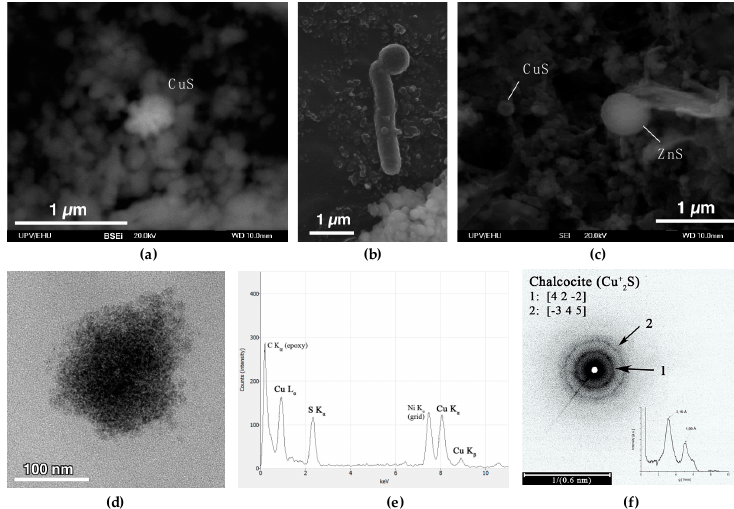
Figure 4. SEM ( a – c ) and TEM ( d – f ) images obtained on suspended particulate matter sampled at 43 m ( a ) and 47 m ( b – f ) depth in the acidic pit lake of Filón Centro in October 2018; ( a ) backscattered electron image of lenticular aggregate of chalcocite-like Cu sulfide; ( b ) mineralized bacterial rod associated with a spherical particle; ( c ) secondary electron image of globular ZnS with trace Cd and small darker particles which are globular Cu sulfides; ( d ) globular chalcocite (Cu 2 S) particle from SPM at 47m; ( e ) EDS pattern of the particle shown in ( d ) confirming composition dominated by Cu and S; ( f ) TEM selected area electron diffraction of globular sulfide shown in ( d ) with arrows indicating diffraction rings and calculated profile inset, characteristic of chalcocite (Cu 2 S) with 0.01 degree of confidence.